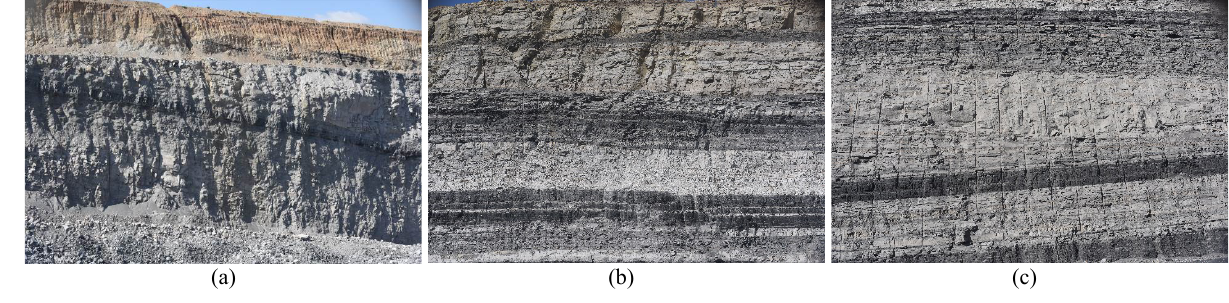
Figure 1 . From left to right: a) test site TS A, b) test site TS B, and c) test site TS C.